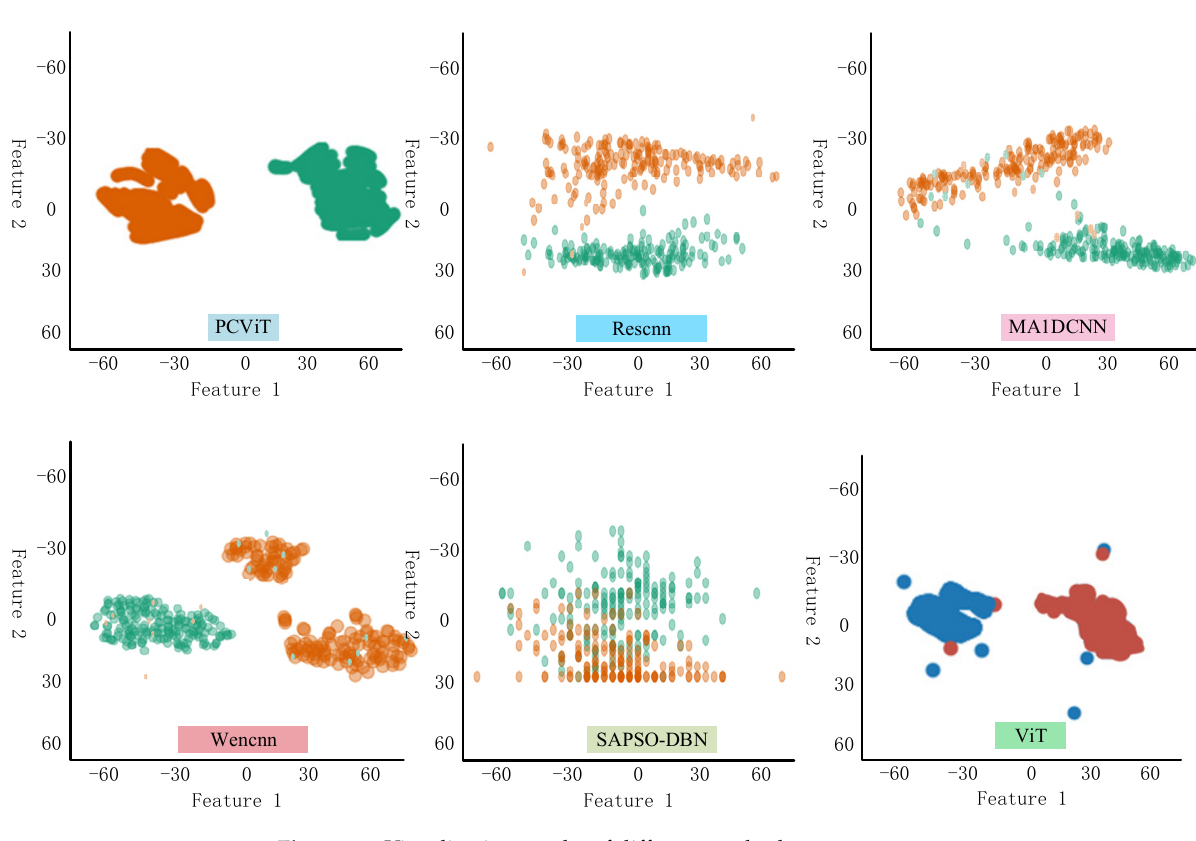
Figure 12. Visualization results of different methods.